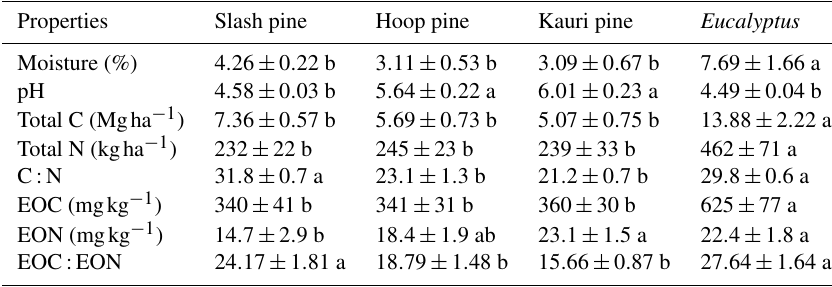
Table 1. Soil biochemical properties in 78-year-old forest plantations with different tree species. Properties Slash pine Hoop pine Kauri